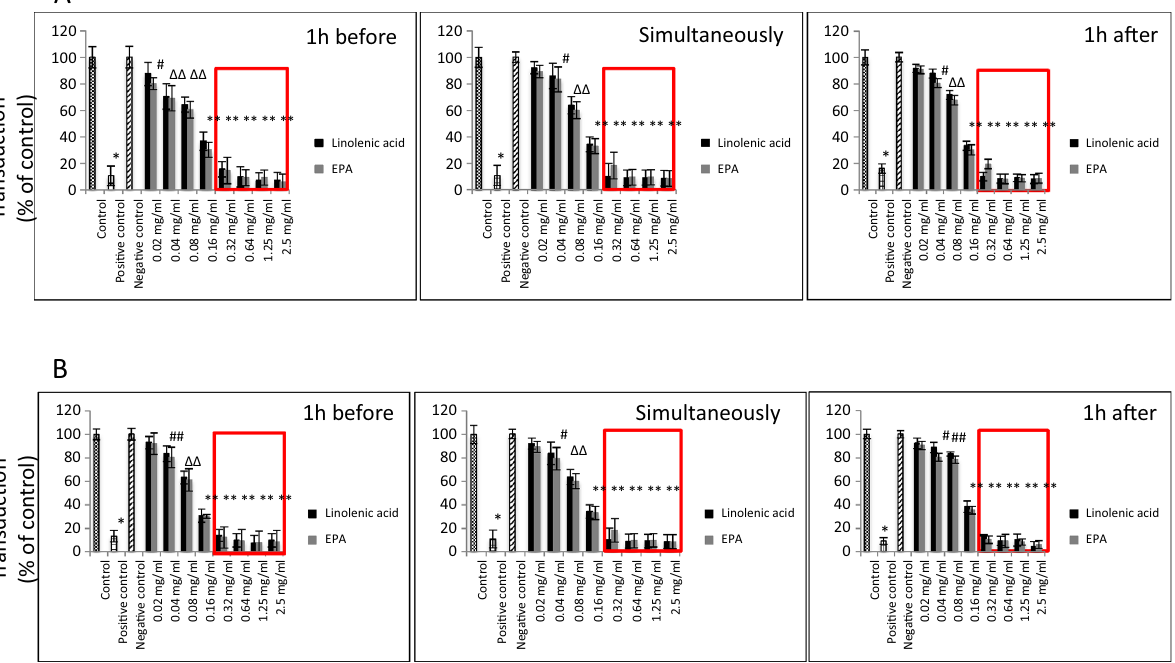
Figure 4. SARS-CoV-2 eGFP-luciferase-pseudo-virion binding and cellular entry. Binding and entry of SARS- CoV-2 pseudo-virions with encapsulated eGFP-luciferase spike protein was evaluated without spinfaction and with spinfaction. ( A ) A549 cells stably overexpressing hACE2 receptor were inoculated (no spinfection) with SARS-CoV-2 pseudo-virions treated with indicated FAs at different concentrations and time. After 48 h post-inoculation time, transduction efficacy was measured according to luciferase activity. ( B ) Binding and entry of SARS-CoV-2 pseudo-virions with encapsulated eGFP-luciferase Spike protein. A549 cells stably overexpressing hACE2 receptor were inoculated (spinfection) with SARS-CoV-2 pseudo-virions treated with indicated FAs at different concentrations and time. After 48 h post-inoculation time, transduction efficacy was measured according to luciferase activity. Data are presented as % of control ± SD; # p ≤ 0.05, ∆ p ≤ 0.01, * p ≤ 0.001. Control—0.025% DMSO, positive control—bald SARS-CoV-2 eGFP-luciferase-pseudo-virions, negative control—ΔG-luciferase rVSV pseudo-typed particles; red fame—concentrations that showed 85–100%